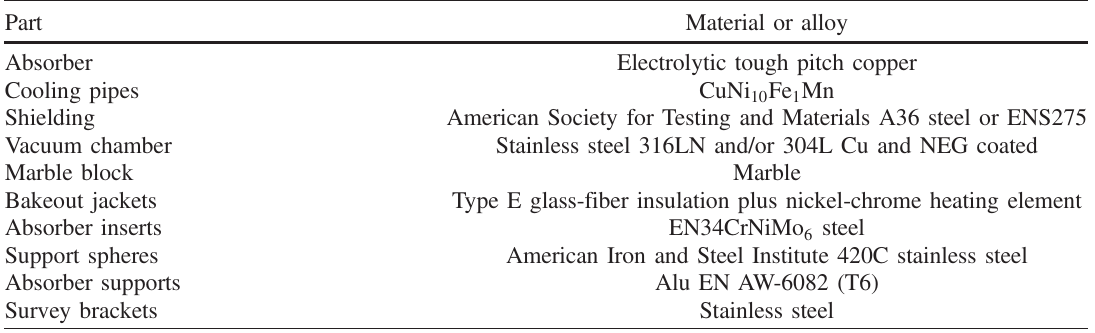
TABLE I. Summary of the main materials used in the construction of the